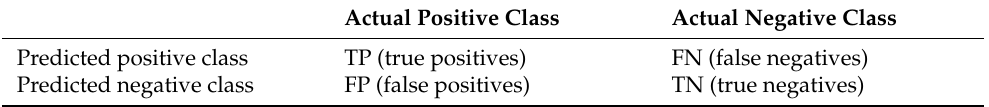
Table 3. The confusion